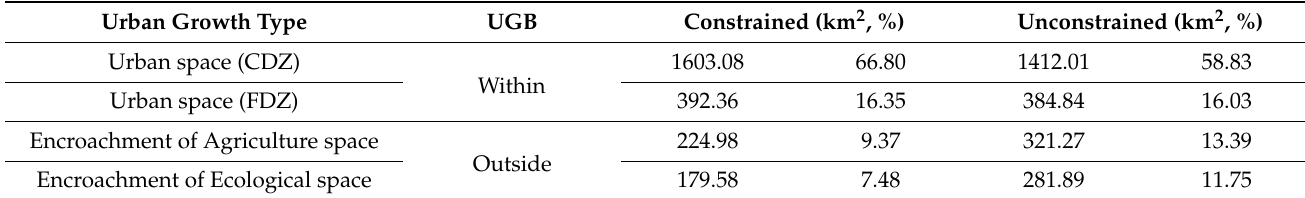
Table 1. Spatial analysis of the two simulation scenarios with